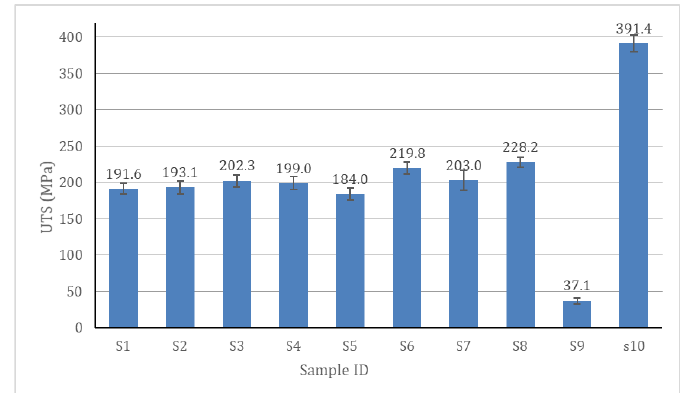
Figure 5: Bar graph showing average UTS values of the different composite panels.